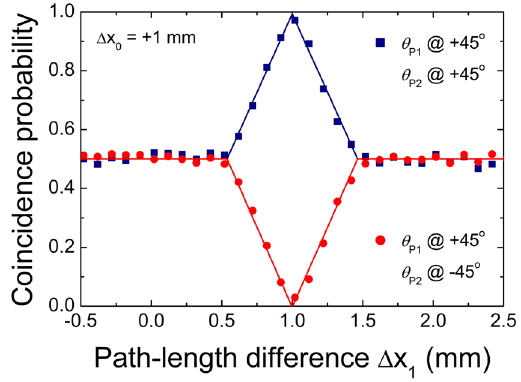
Figure 4. Measured HOM peak and dip fringes as a function of Δ x 1 for degenerate photon pairs when Δ x = + 1 0